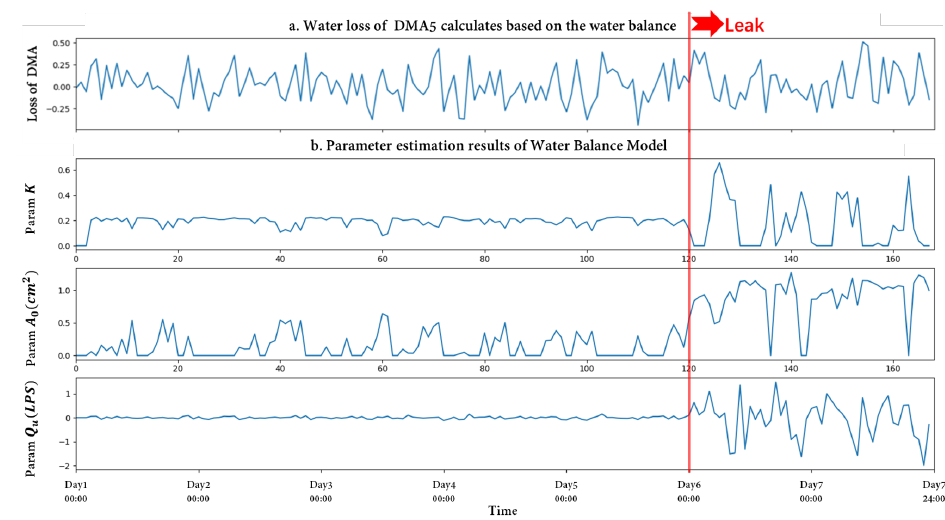
Figure 6. Comparison with a method based on “traditional” water